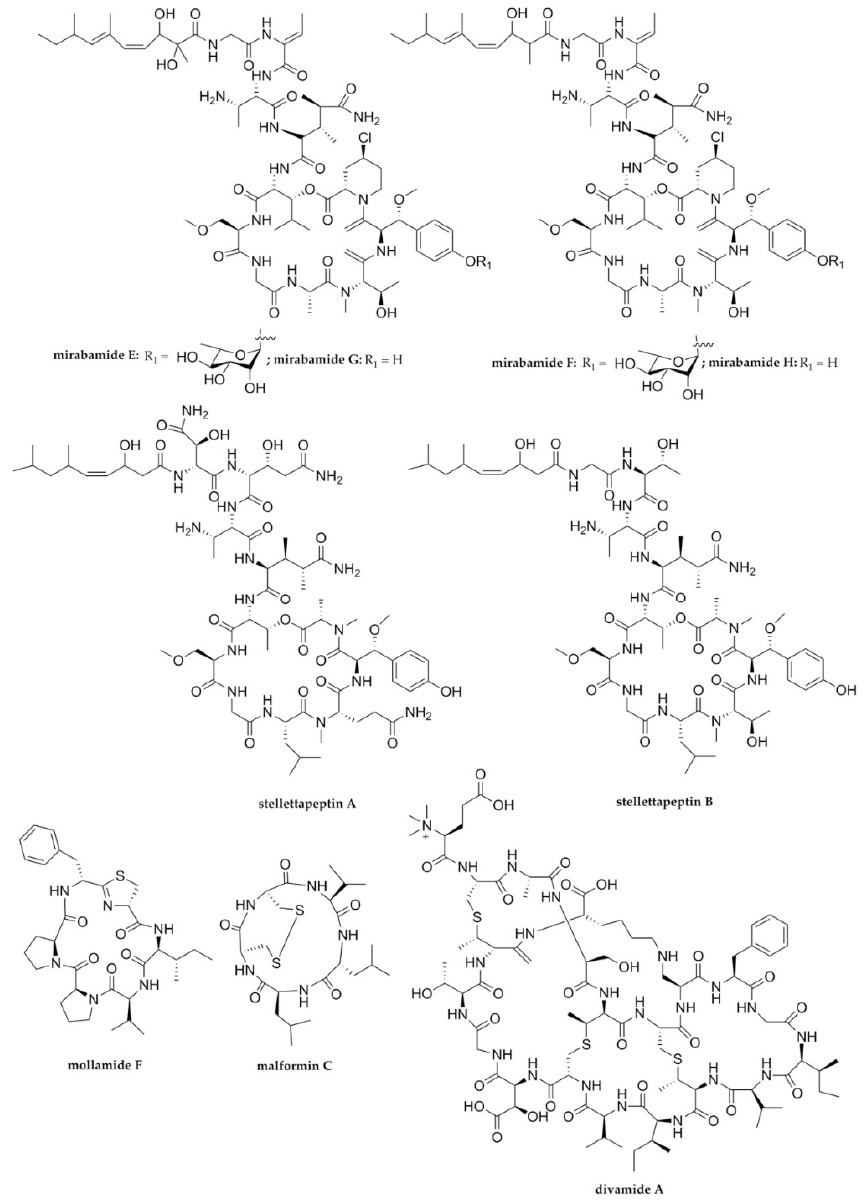
Figure 2. The chemical structures of marine ‐ derived peptides with anti ‐ HIV activity.